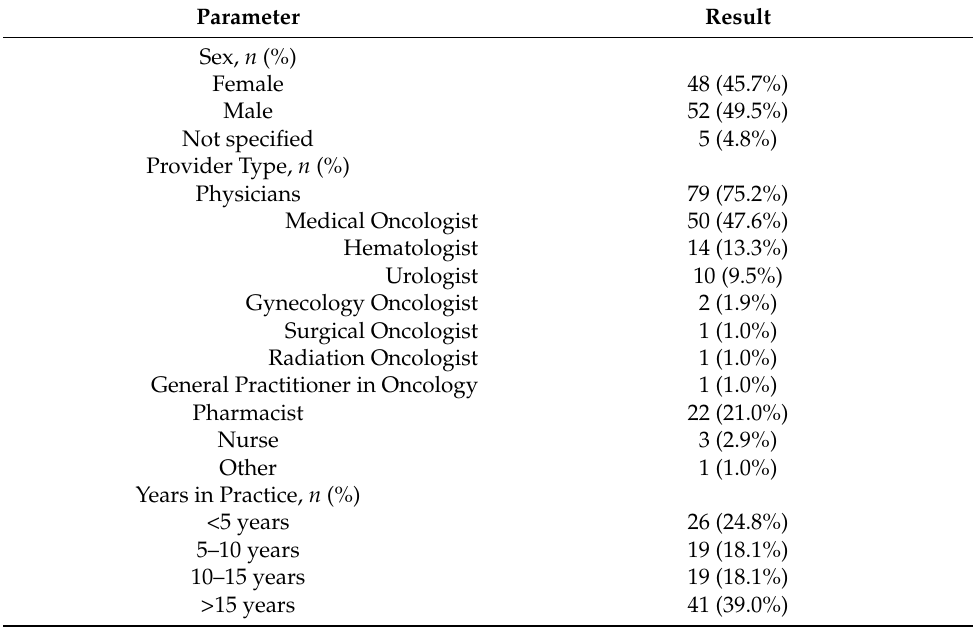
Table 1. Respondent demographics ( n = 105).